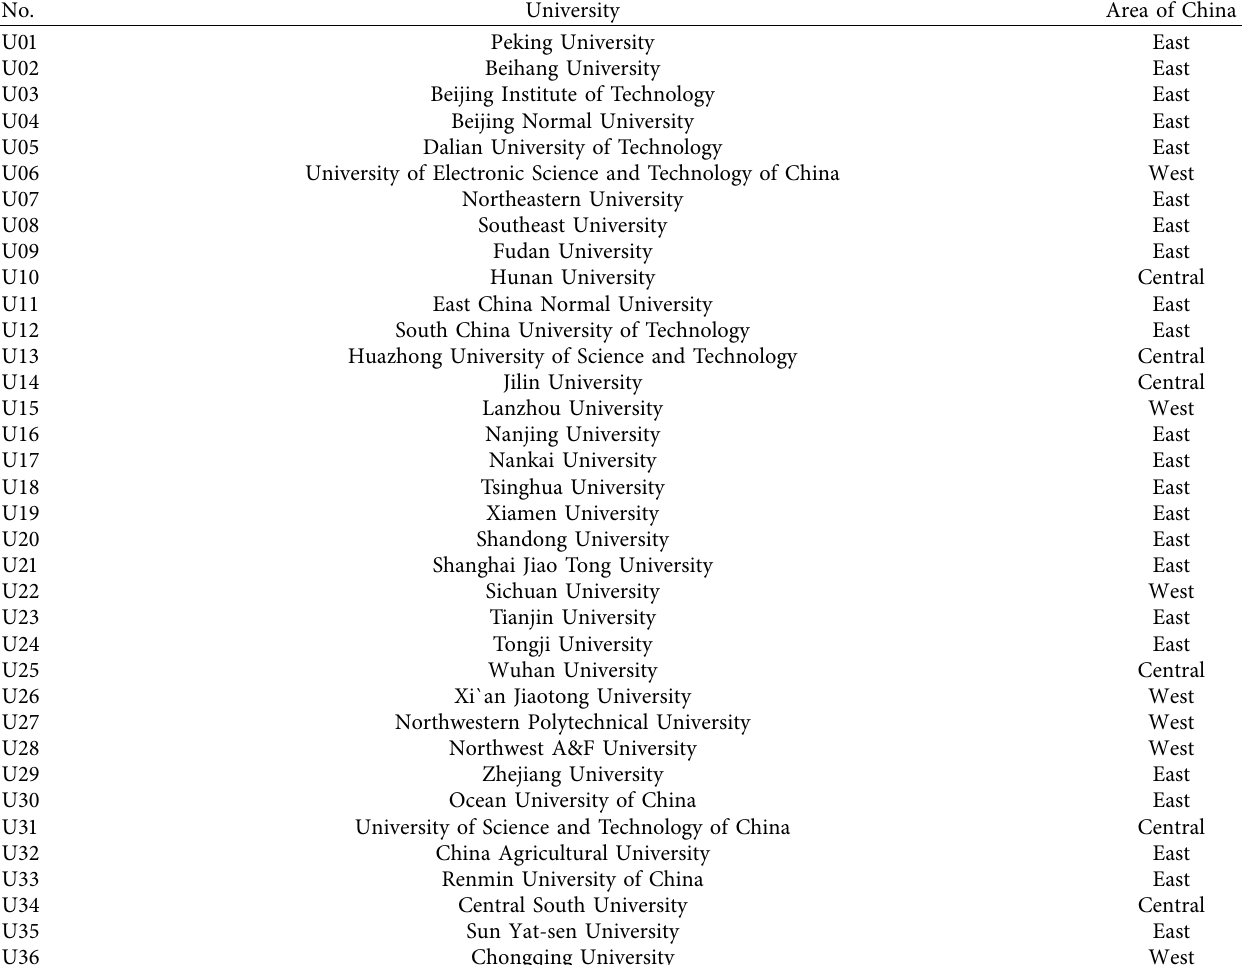
Table 3: The “Double First-Class” universities selected to be evaluated.